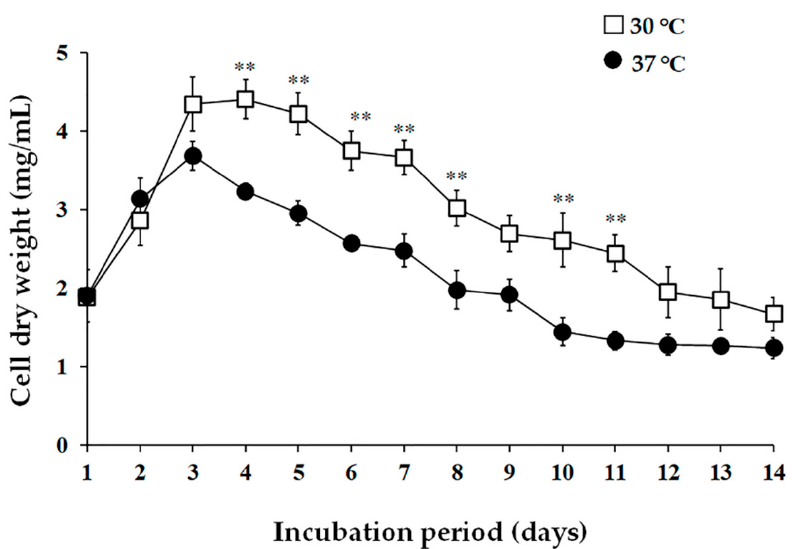
Figure 2. Effect of incubation temperature on the growth of Streptomyces sp. PJ85 cultured in ISP-2 medium. Incubation temperatures: ( □ ) 30 °C and ( ● ) 37 °C. Error bars represent the standard deviation of the mean ( n = 3). The statistical significance of the differences between the cell biomass of PJ85 cultured at 30 °C and 37 °C was estimated using a two-way ANOVA with a Bonferroni multiple comparison test, ** p < 0.0001, compared on the same incubation day.